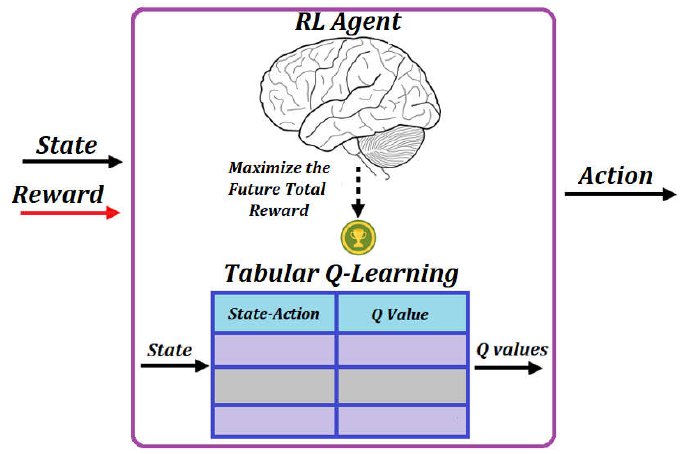
Figure 3. The Q -learning RL agent.